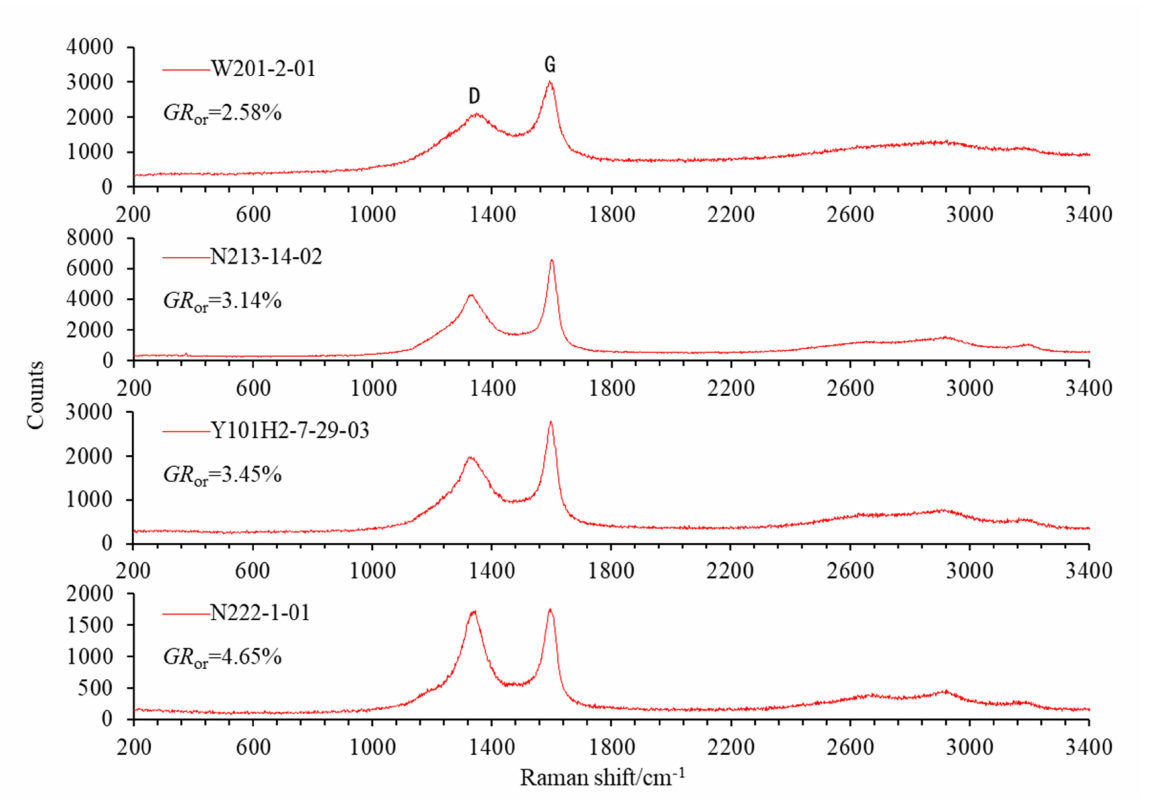
Figure 7. Raman spectra for solid organics with different